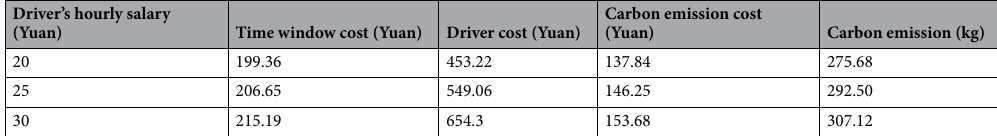
Table 6. The effect of various